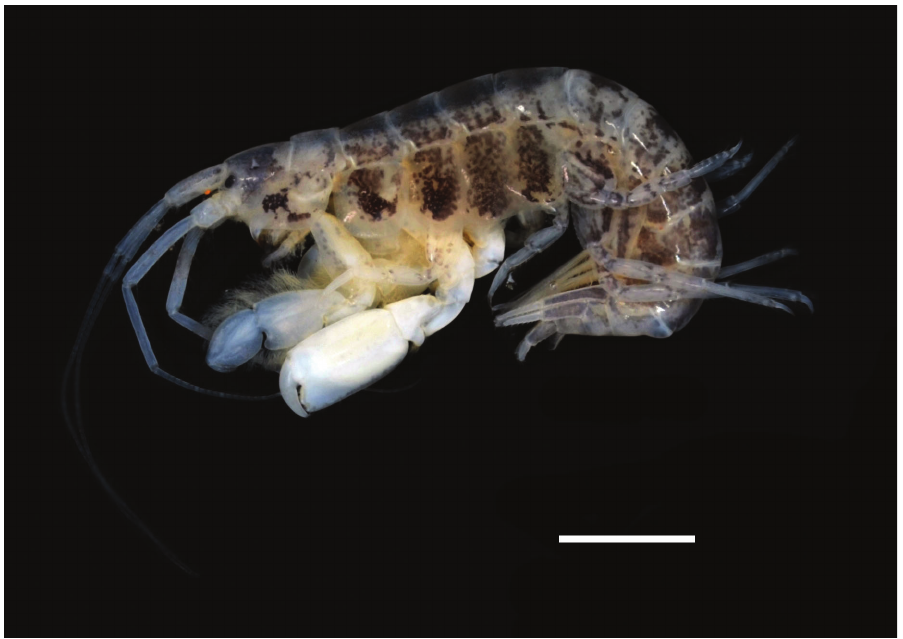
Figure 1. Photograph of the Ampithoe changbaensis sp. nov., habitus of the male paratype. Scale bar: 5 mm. Photograph by Jin-Ho